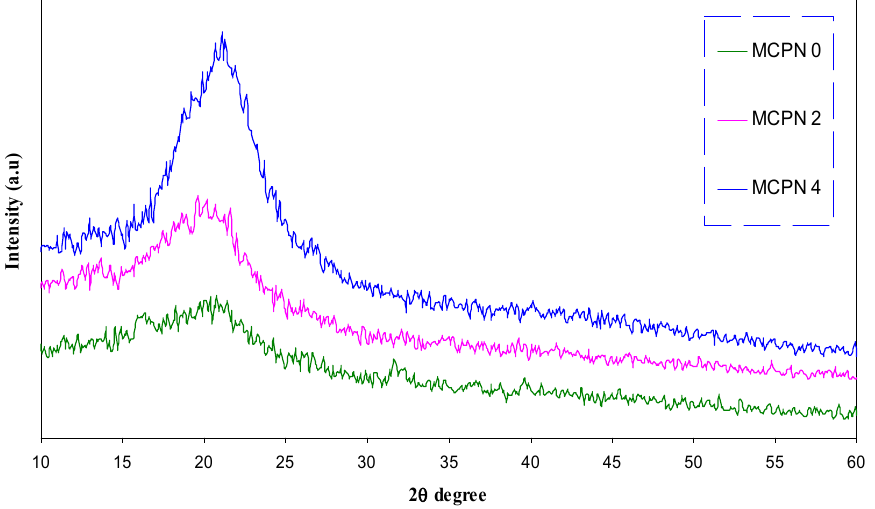
Figure 11. XRD pattern of pure MC and doped MC samples.